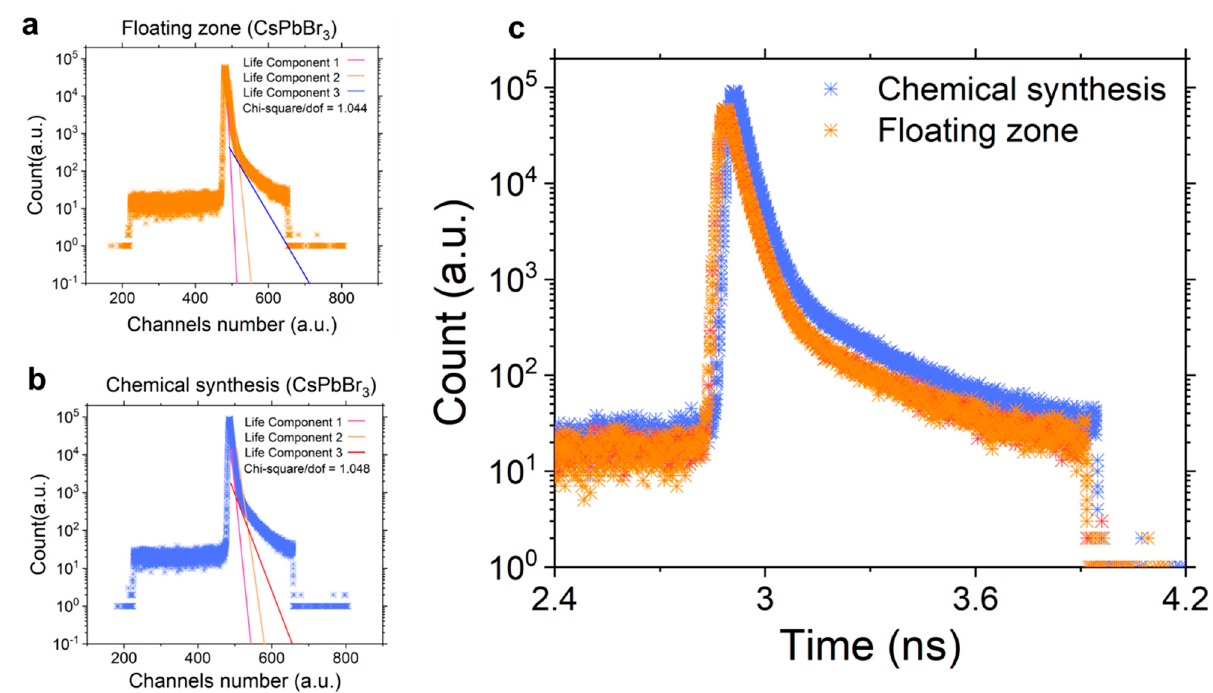
Figure 4. Positron Annihilation Lifetime Spectroscopy (PALS) analysis for CsPbBr 3 depicting the three-lifetime components for crystal obtained using ( a ) floating zone and ( b ) chemical synthesis method. ( c ) comparison of positron lifetime from chemical synthesis and floating zone method.